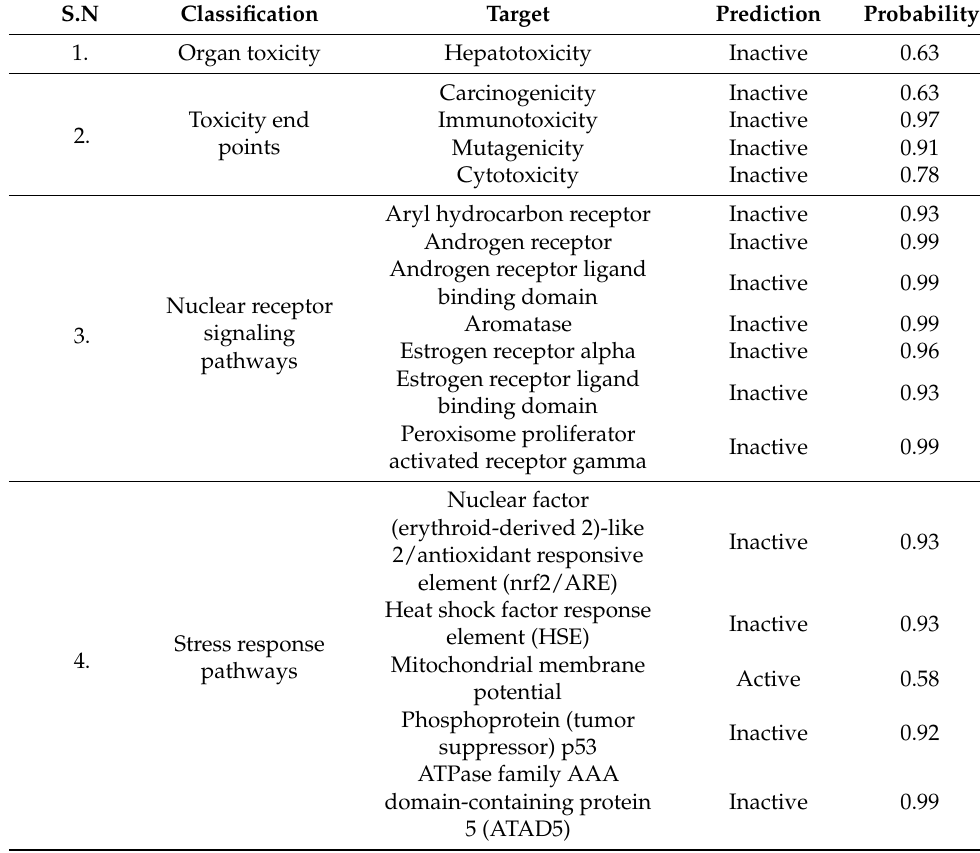
Table 2. TQ toxicity determined by ProTox-II webserver.